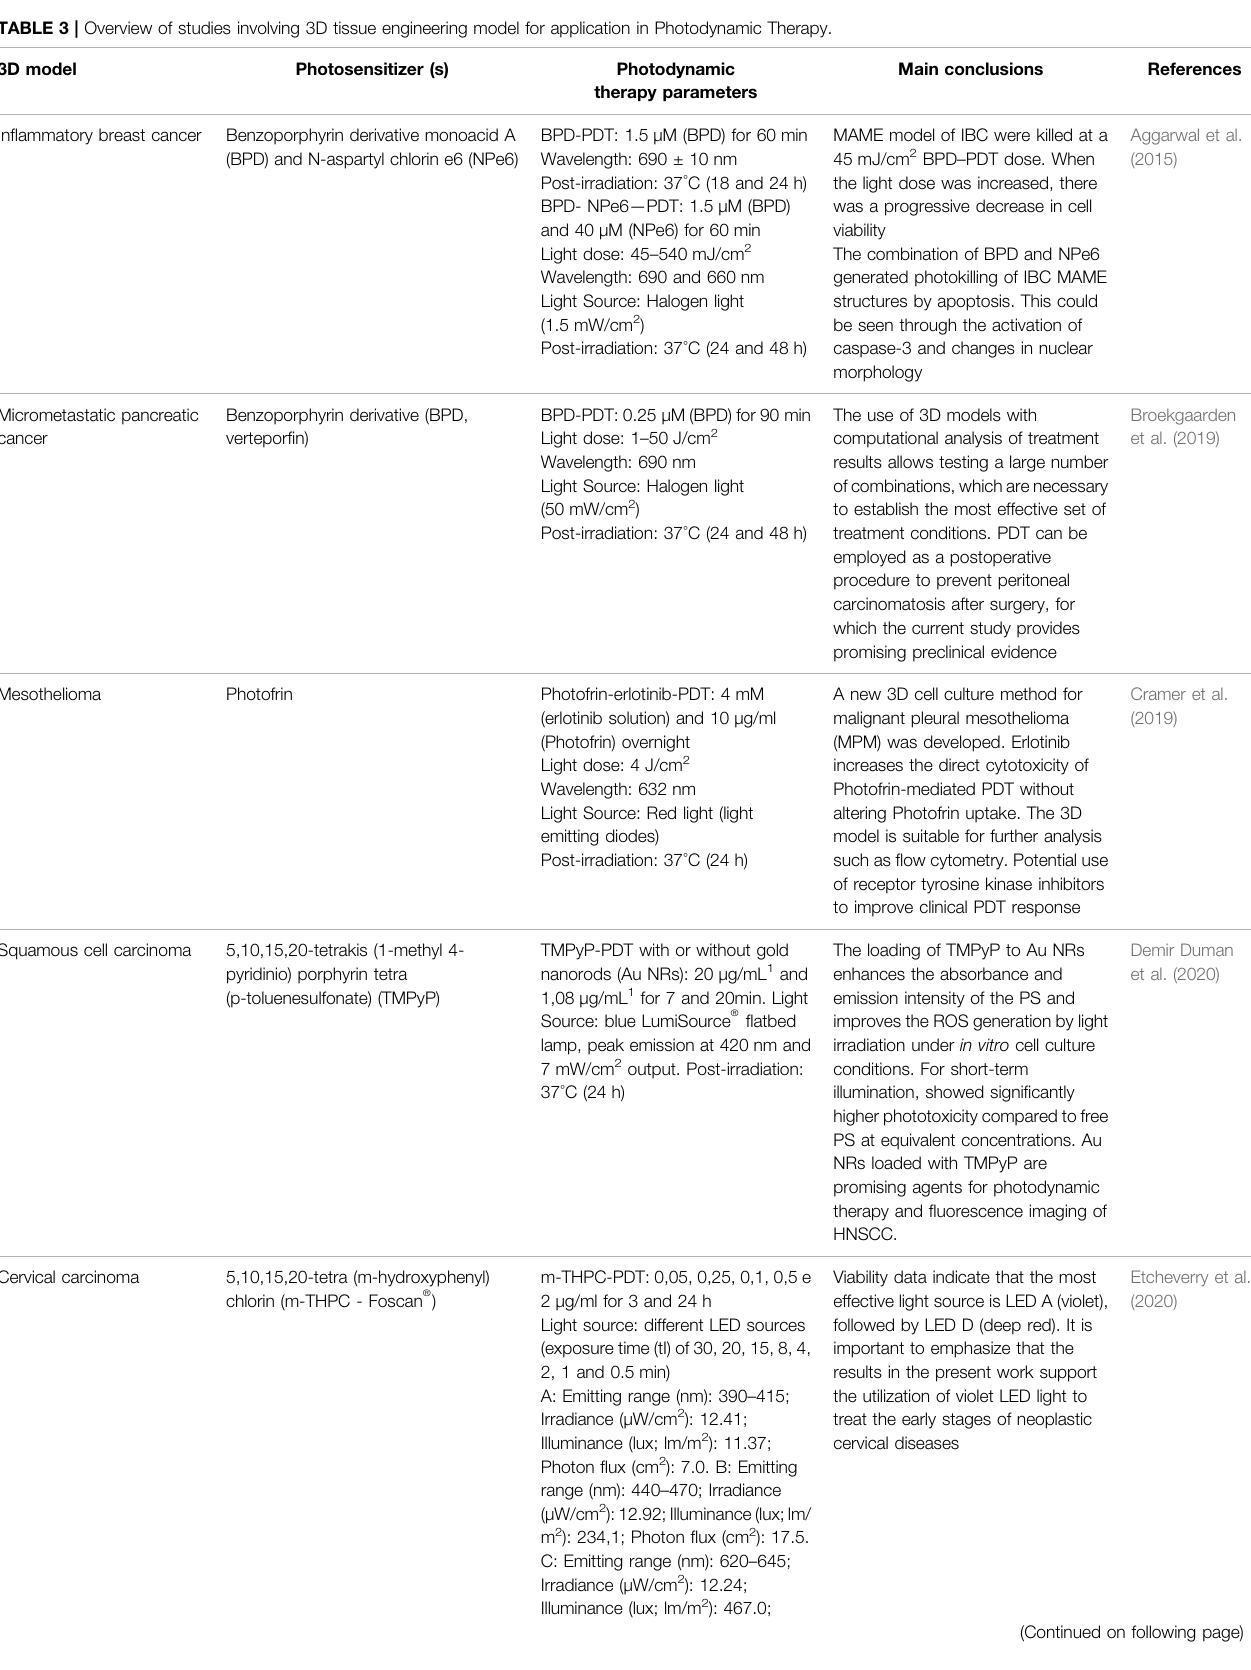
TABLE 3 | Overview of studies involving 3D tissue engineering model for application in Photodynamic